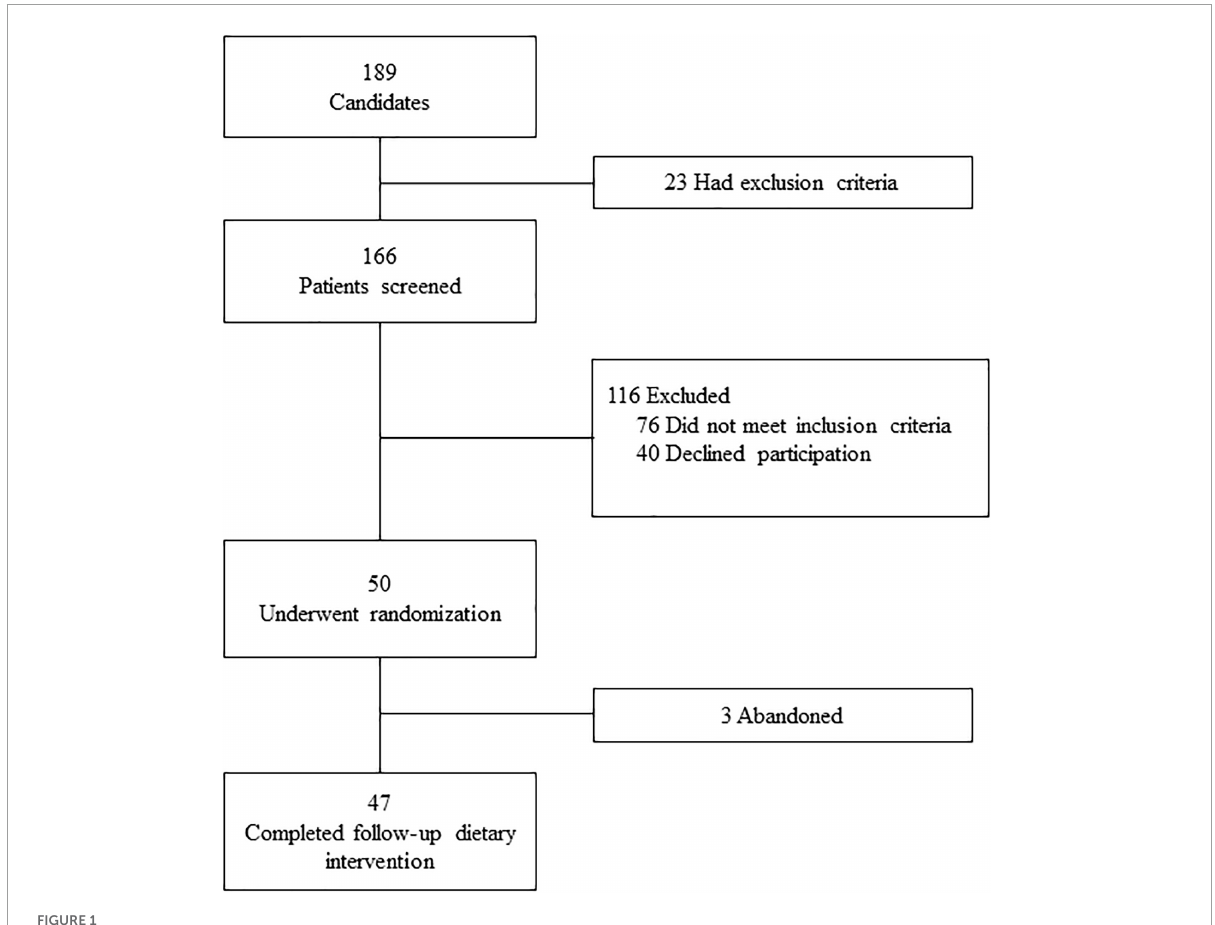
FIGURE1 Screening, selection and recruitment flow-chart of patients for the study.